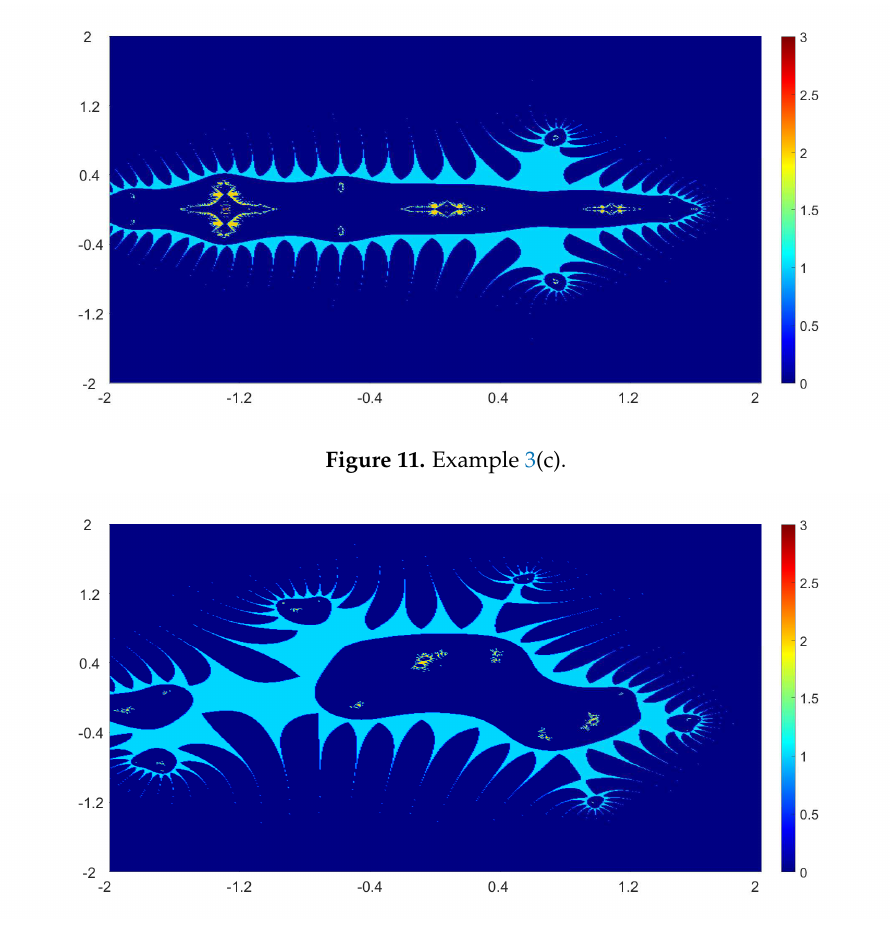
Figure 12. Example 3(d).